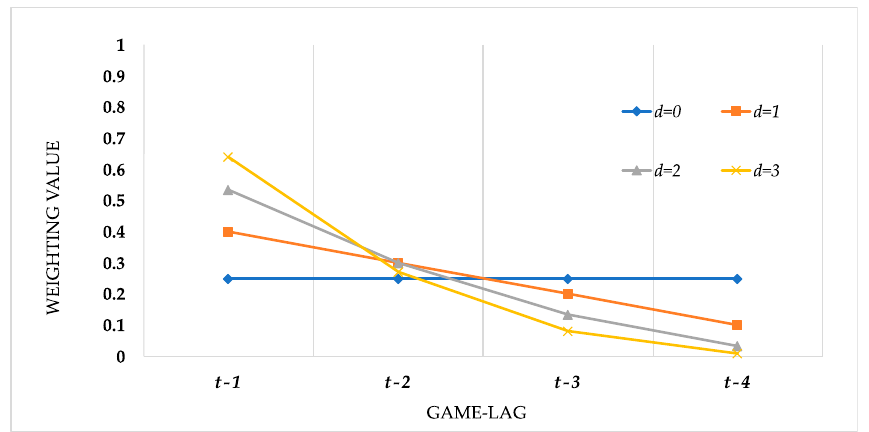
Figure 3. Weighting distribution of each data point with different weighting control parameter ( d ) from 0 to 3 under game-lag = 4.